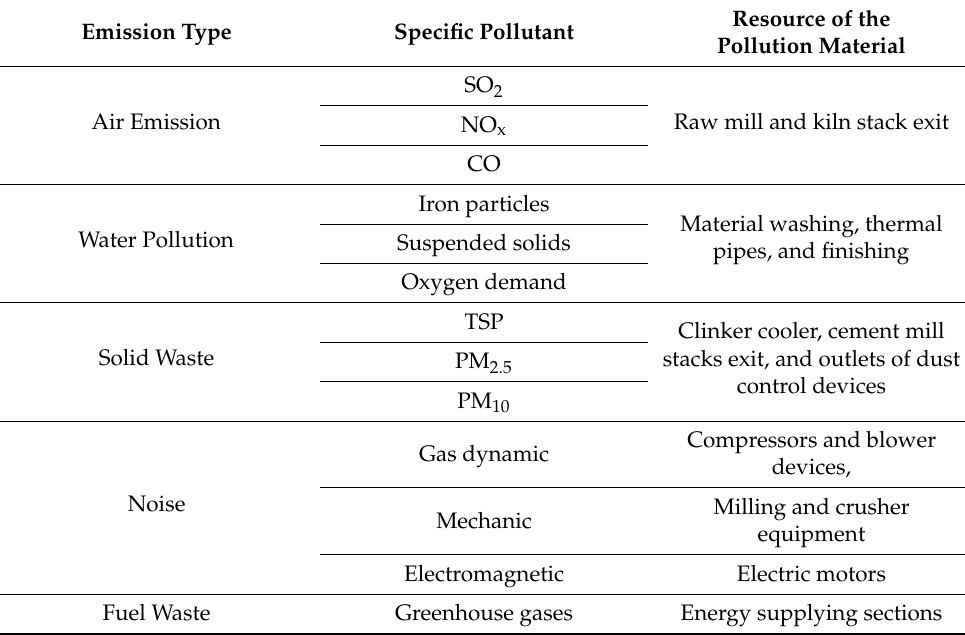
Table 1. Main pollutants from the cement plants and their major